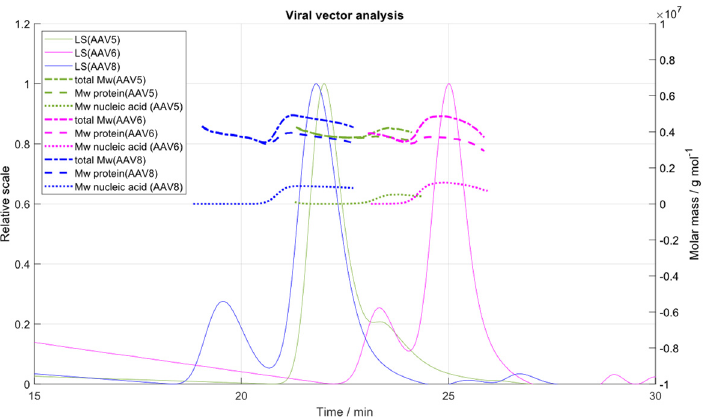
Figure 5. Overlay of the LS chromatograms (solid lines) and molar masses of the total capsid, protein and transgene (dashed lines) of serotypes AAV5 (green), AAV6 (pink) and AAV8